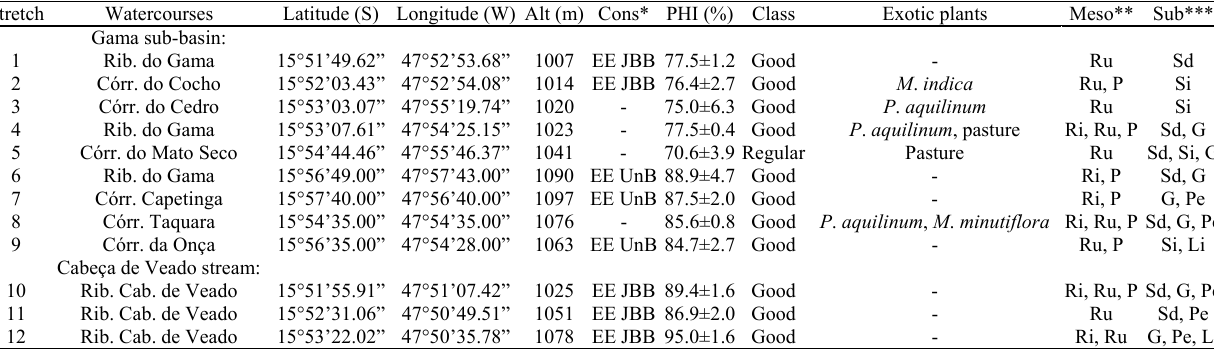
Table 1. Sample units located in the APA Gama and Cabeça de Veado with their respective watercourses names, coordinates, altitude (Alt), integral protection conservation units (Cons*), Physical Habitat Index (PHI), and classification (Class), exotic plant species that compose the riparian vegetation, types of mesohabitats (Meso**), and main substrate types (Sub***). *